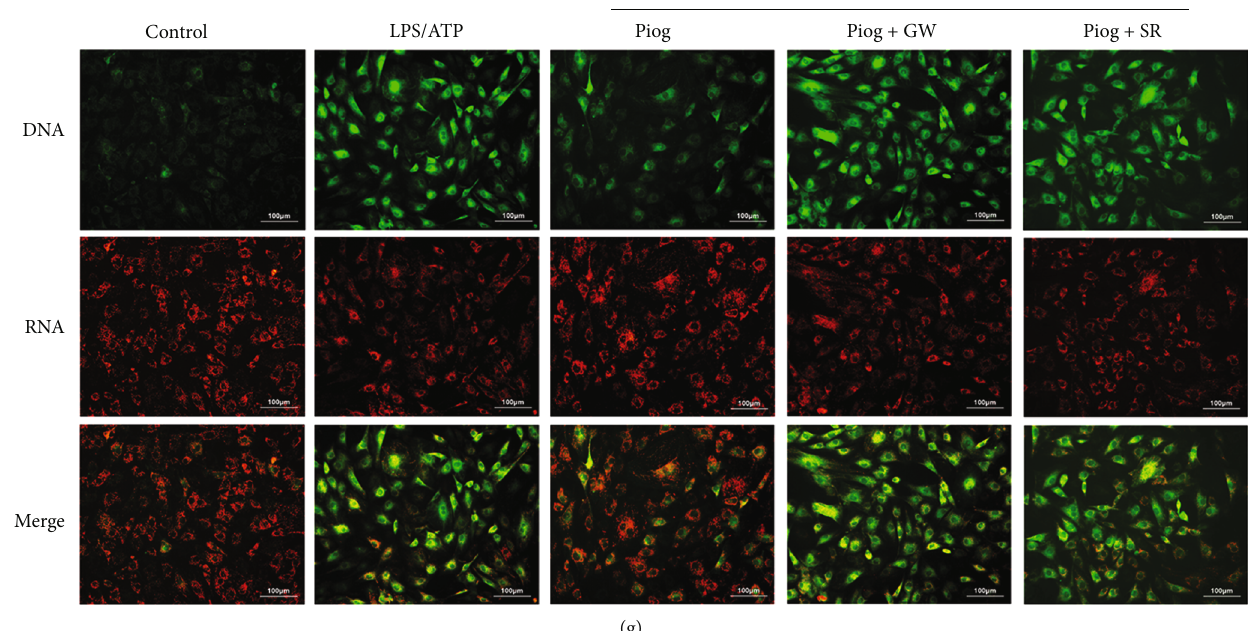
Figure 5: Piog partially attenuates LPS/ATP-induced pyroptosis of chondrocytes through the PGC1- α / Δψ signaling pathway. (a) PPAR- γ m activation by Piog rescued PGC1- α expression in the presence of LPS/ATP. Western blot analysis for PGC1- α in the control, LPS/ATP, Piog +LPS/ATP, and Piog+GW+ LPS/ATP groups. (b) Cells were pretreated with Piog in the presence or absence of SR and then stimulated with LPS/ATP. The level of NLRP3 was detected using western blotting. (c) ELISA was performed to measure IL-1 β and IL-18 levels in the control, LPS/ATP, Piog+ LPS/ATP, and Piog+ SR+LPS/ATP groups. (d) CCK8 assays were performed to determine the chondrocyte viability in the control, LPS/ATP, Piog+ LPS/ATP, and Piog+SR +LPS/ATP groups. (e) The intracellular ROS content was detected in assays. (f and g) The ratio of red fl uorescent emission of cells with intact Δψ against green fl uorescent the same fi ve groups using Δψ m m was plotted to represent the changes in Δψ . Fluorescent spectrophotometry was used to detect the emission of cells with impaired Δψ m m Δψ of JC-1-stained cells in the control, LPS/ATP, Piog+ LPS/ATP, GW+Piog+ LPS/ATP, and SR+ Piog+LPS/ATP groups (bar: m 100 μ m). GAPDH was used as an internal reference for western blotting. The characteristic immunoblot pictures are located under their densitometric analysis. The data represent three independent experiments and are expressed as mean ± SD. ** P < 0 : 01